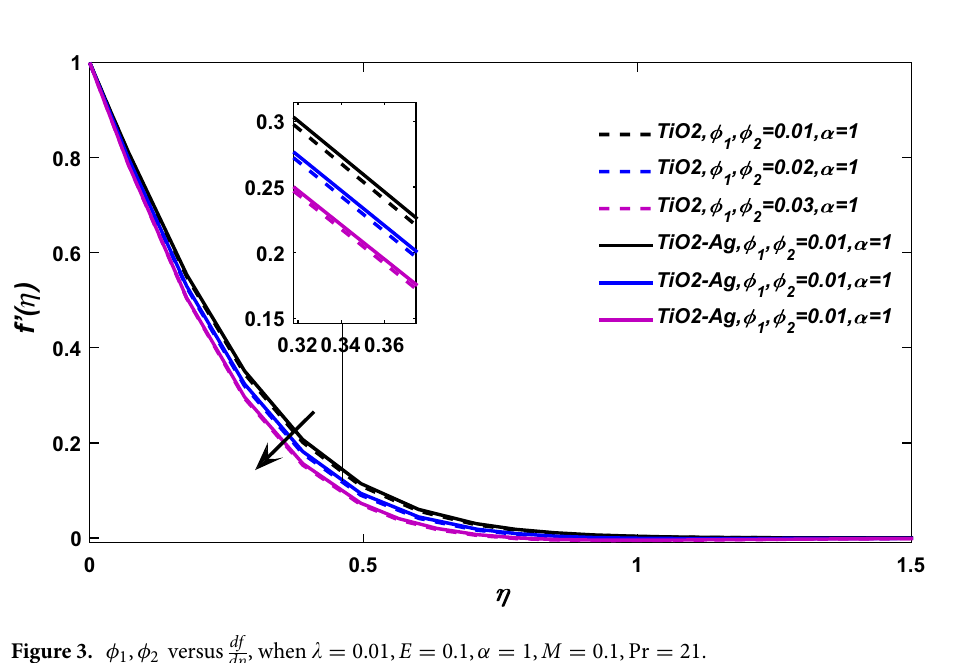
Figure 3. φ 1 , φ 2 versus df d η , when (cid:31) = 0.01, E = 0.1, α = 1, M = 0.1, Pr =